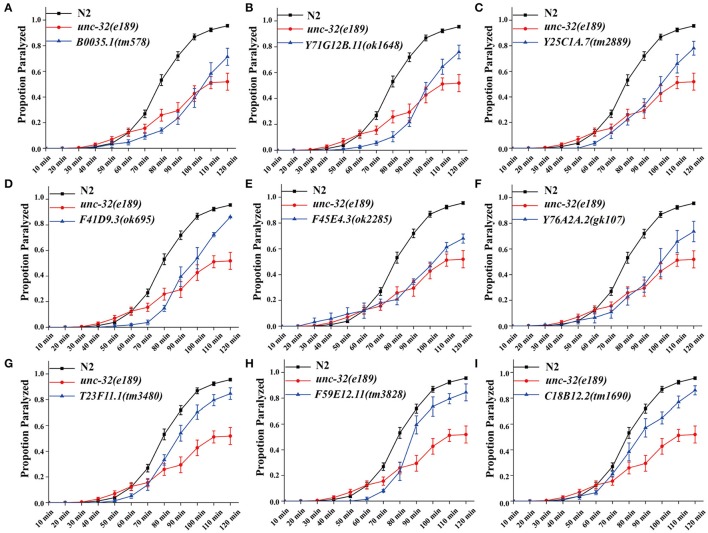
Deletion mutants of candidate genes show acetylcholine secretion defects. Acetylcholine release was detected by determining the proportion of paralyzed animals exposed to 1 mM aldicarb. (A–I) Proportion paralyzed over time from indicated deletion mutant worms. Worm strains of B0035.1(tm578), Y71G12B.11(ok1648), Y25C1A.7(tm2889), F41D9.3(ok695), F45E4.3(ok2285), Y76A2A.2(gk107), T23F11.1(tm3480), F59E12.11(tm3828), and C18B12.2(tm1690) exhibited aldicarb-resistance. UNC-32(e189) as aldicarb resistant positive control. 25–35 young adult animals were tested for each experiment, at least three independent experiments were performed. Error bars represent SEM.